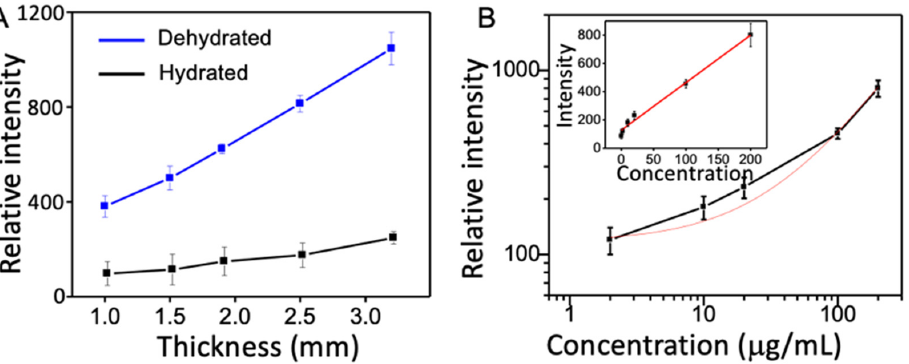
Figure 5. Relative intensity of X-ray fluorescence before (black) and after (blue) dehydration of hydrogels of different thickness ( A ). The relation between X-ray fluorescence intensity and avidin concentration in logarithmic form ( B ) and in linear form (B inset).